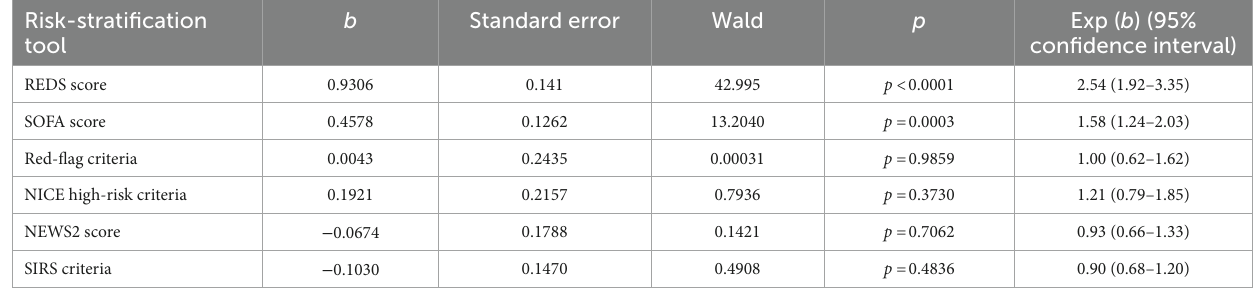
TABLE 3 Cox proportional hazard regression of the six risk-stratification tools.